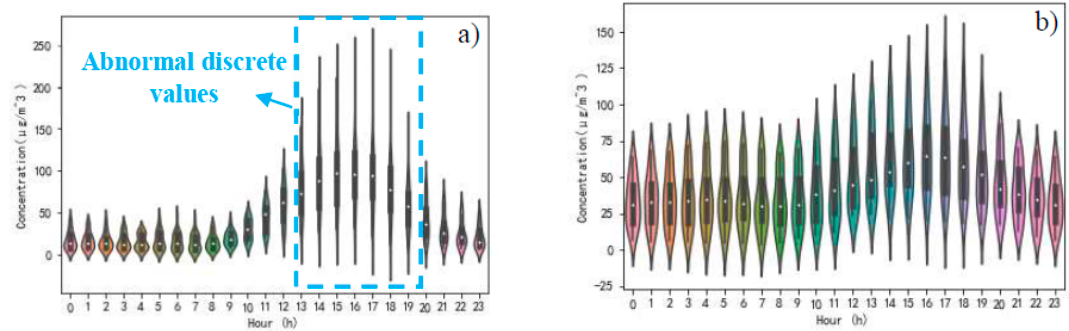
Figure 7. Time distribution characteristics of SO 2 concentration, ( a ) in case one, ( b ) in case two.